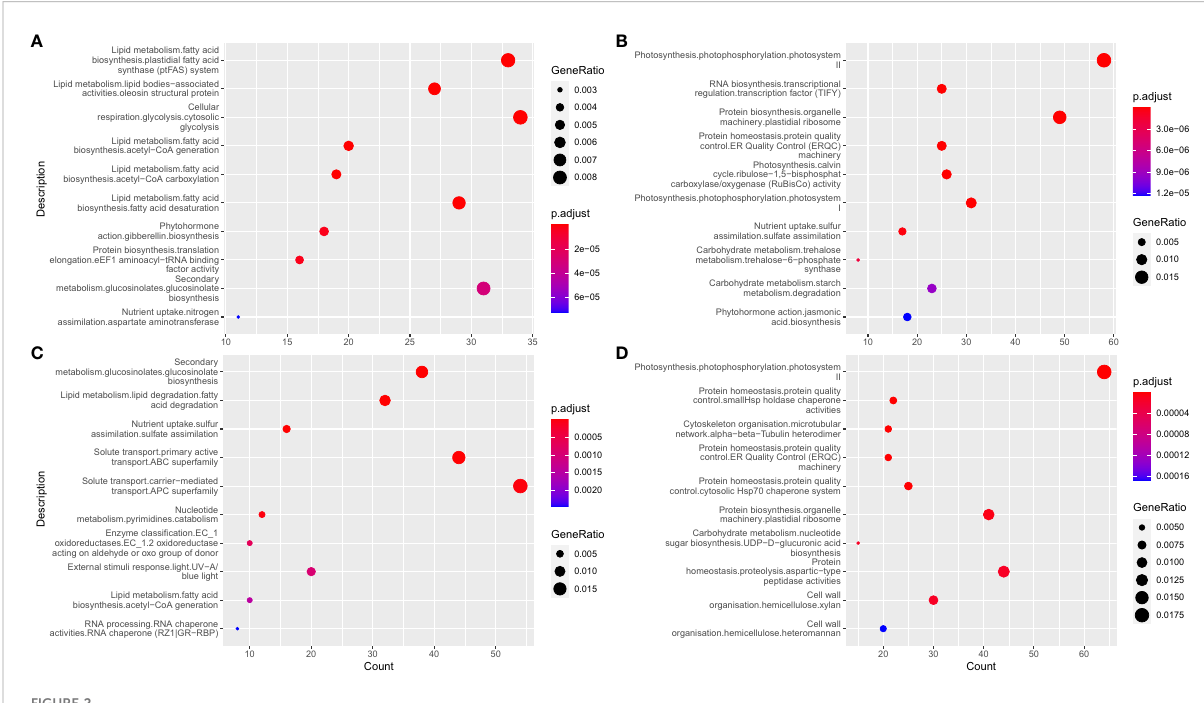
FIGURE 2 Enrichment analysis of genes with temporal expression pro fi les. (A, B) enrichment results of signi fi cantly enhanced and inhibited genes over during seed development, respectively. (C, D) enrichment results of signi fi cantly enhanced and inhibited genes during the development of silique walls,